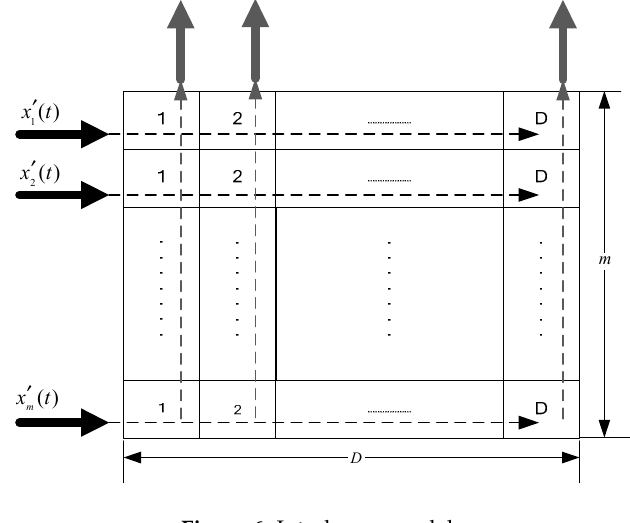
Figure 6. Interleaver model.